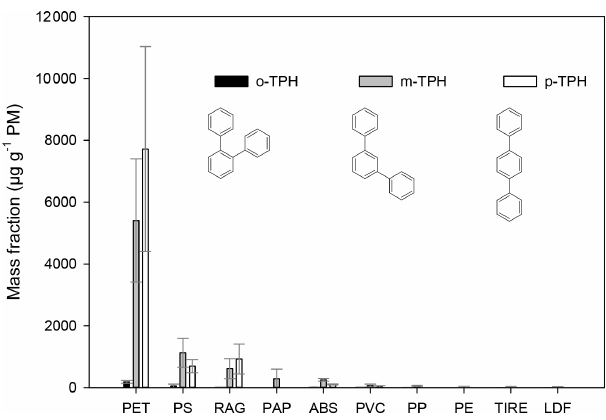
Figure 1. The mass fraction of terphenyls (in units ofµgg − 1 PM − 1 ) in particulates from the burning of different waste types. The error bars represent the standard deviation of the EF data obtained for a given type of waste under different burning